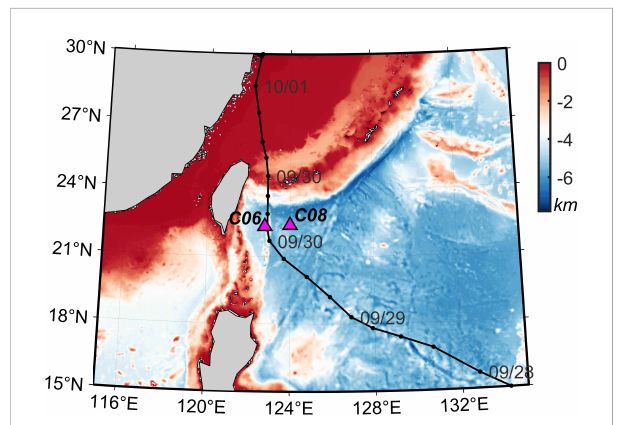
FIGURE 1 Topography east of Taiwan and trajectory of Typhoon MITAG (black line and dots). Pink triangles represent the locations of the ADCP moorings. Time corresponding to some of the black dots is marked in gray letters.